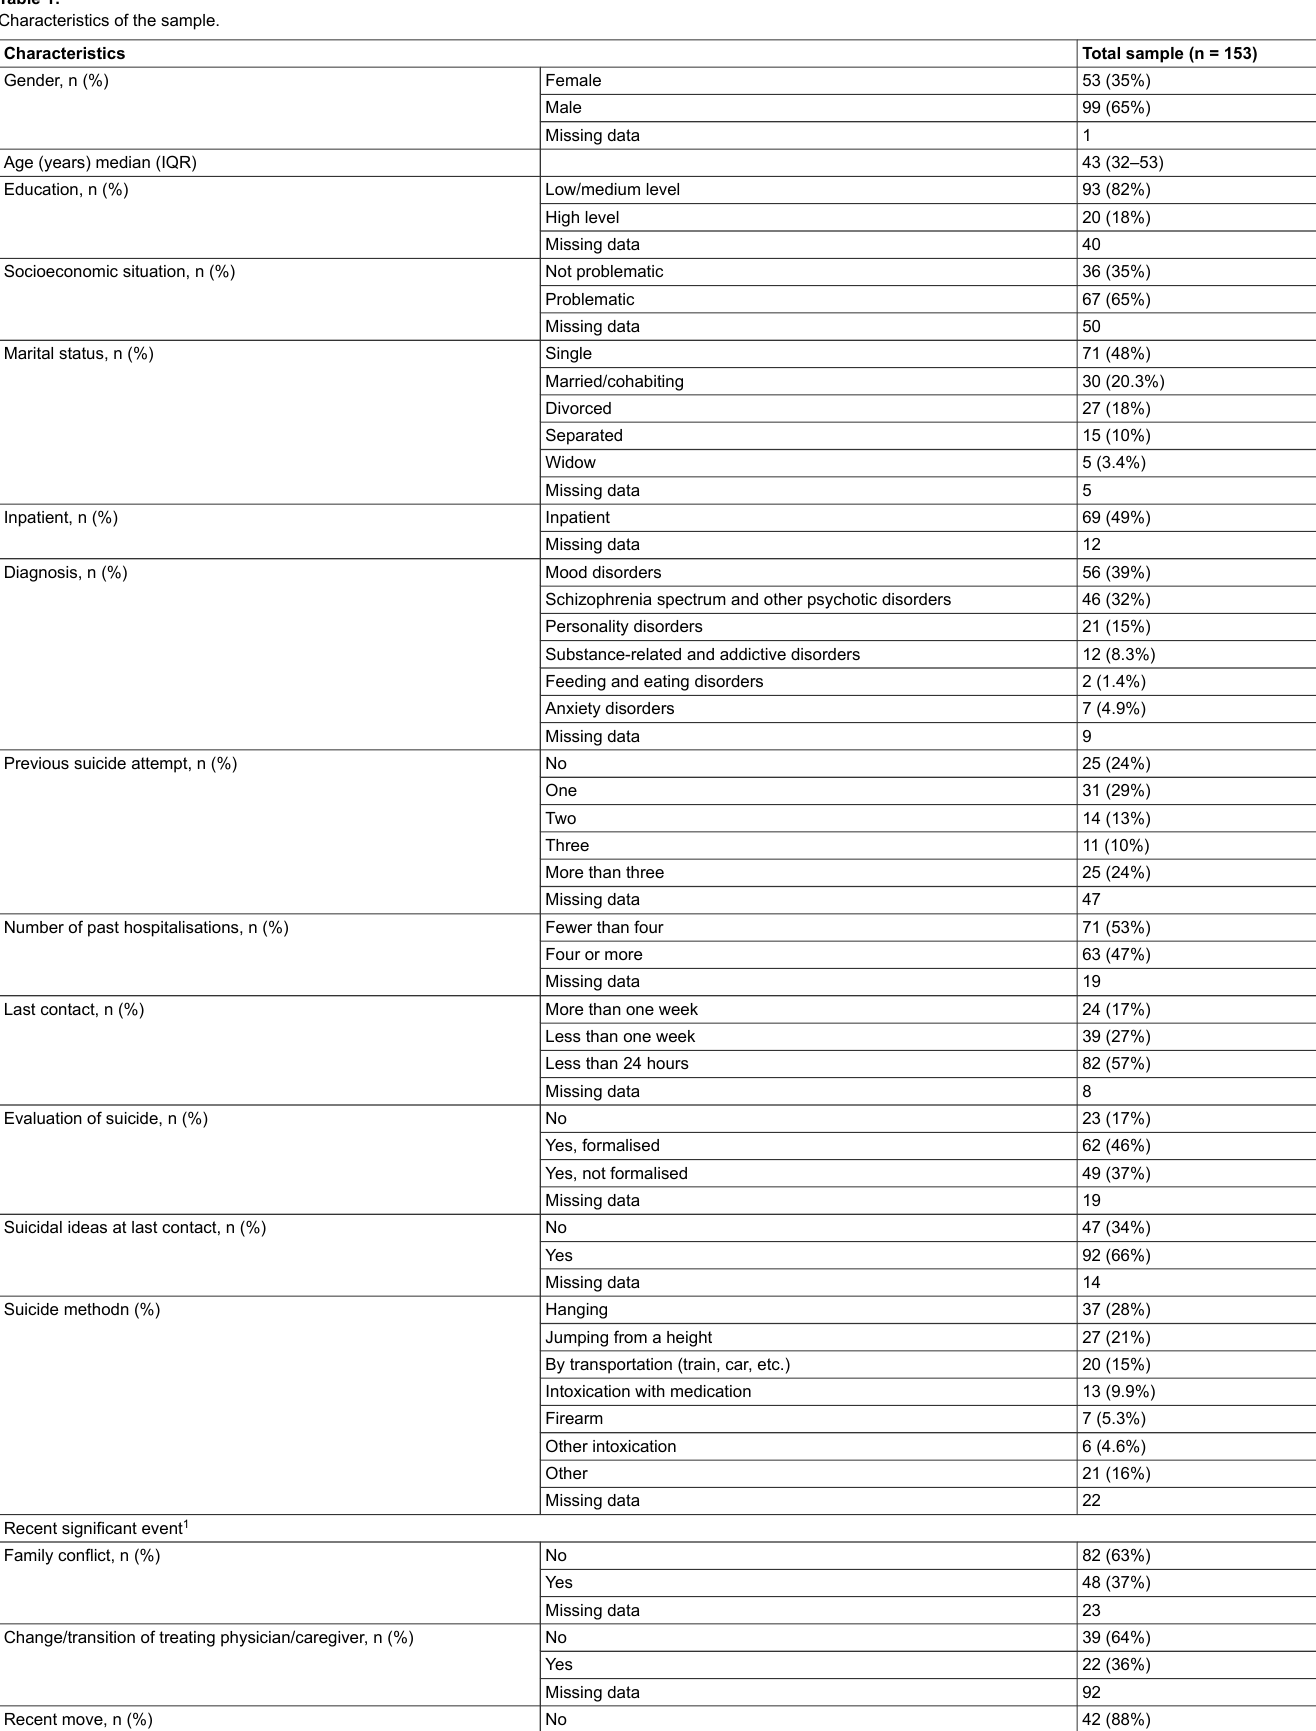
Table 1: Characteristics of the sample.